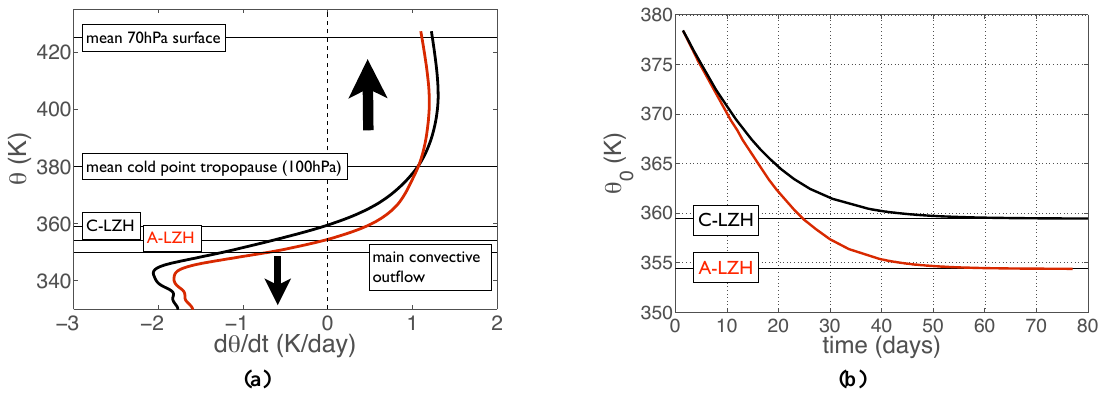
Fig. 1. (a) Annual mean tropical radiative heating rates (30 ◦ S–30 ◦ N) represented as change in potential temperatures, calculated for all-sky (in red) and clear-sky (in black) conditions, using the ERA-Interim dataset for 2005. (b) Time for transport from a source level, θ 0 , to 380K, calculated using the profiles shown in (a)